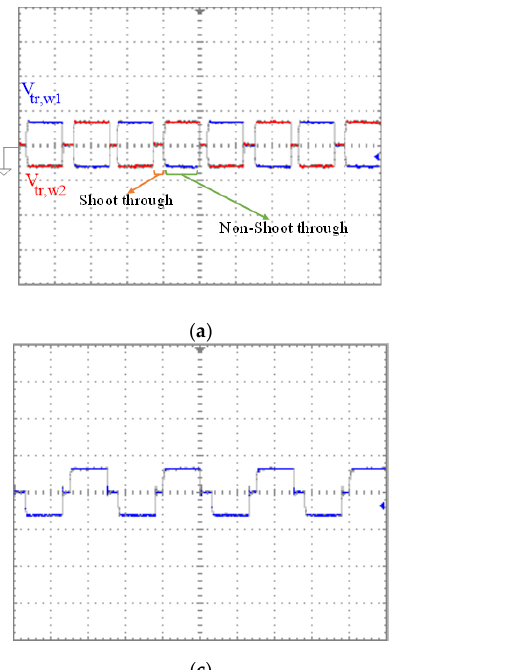
, ( c ) experimental results for I L 1 2 . 2